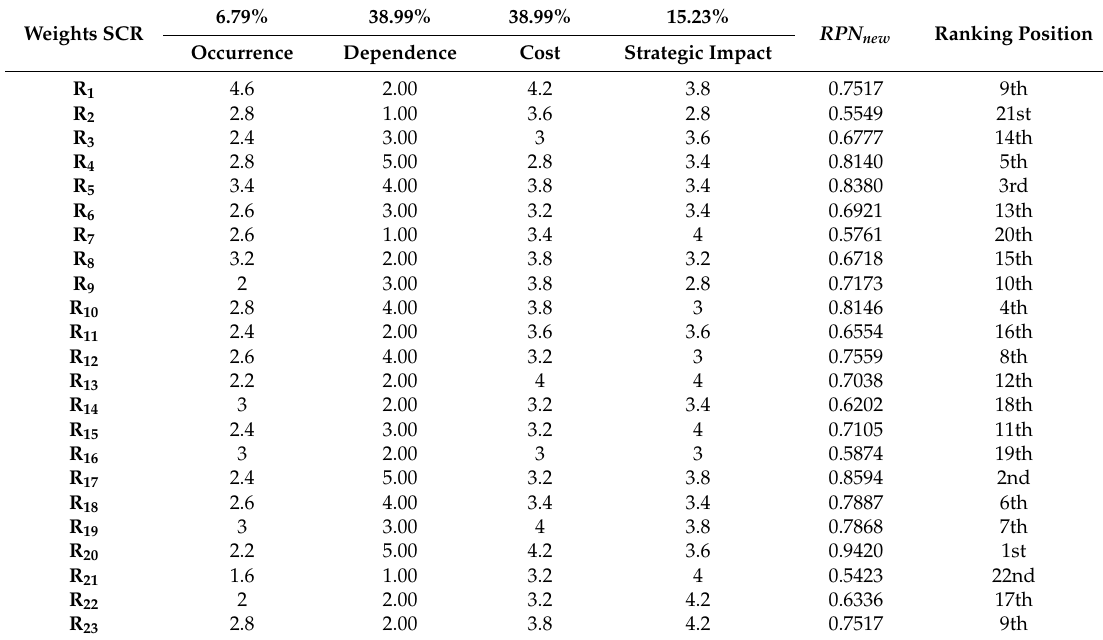
Table 12. New Risk Priority Number (RPN) calculation and final ranking. Weights SCR